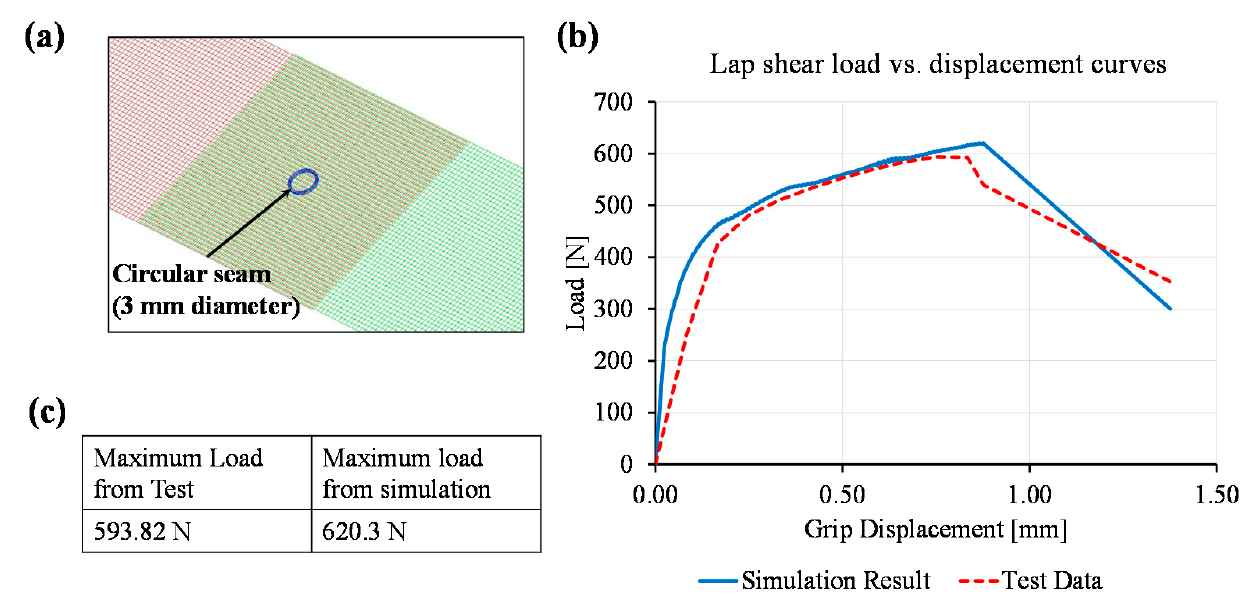
Figure 11. Simulation of lap shear test considering 3 mm diameter circular seam: ( a ) mesh representation of the seam, ( b ) enhanced view of load–displacement curved to show the load–displacement curves obtained from simulation and tensile tests, ( c ) maximum loads obtained from simulation and lap shear test.